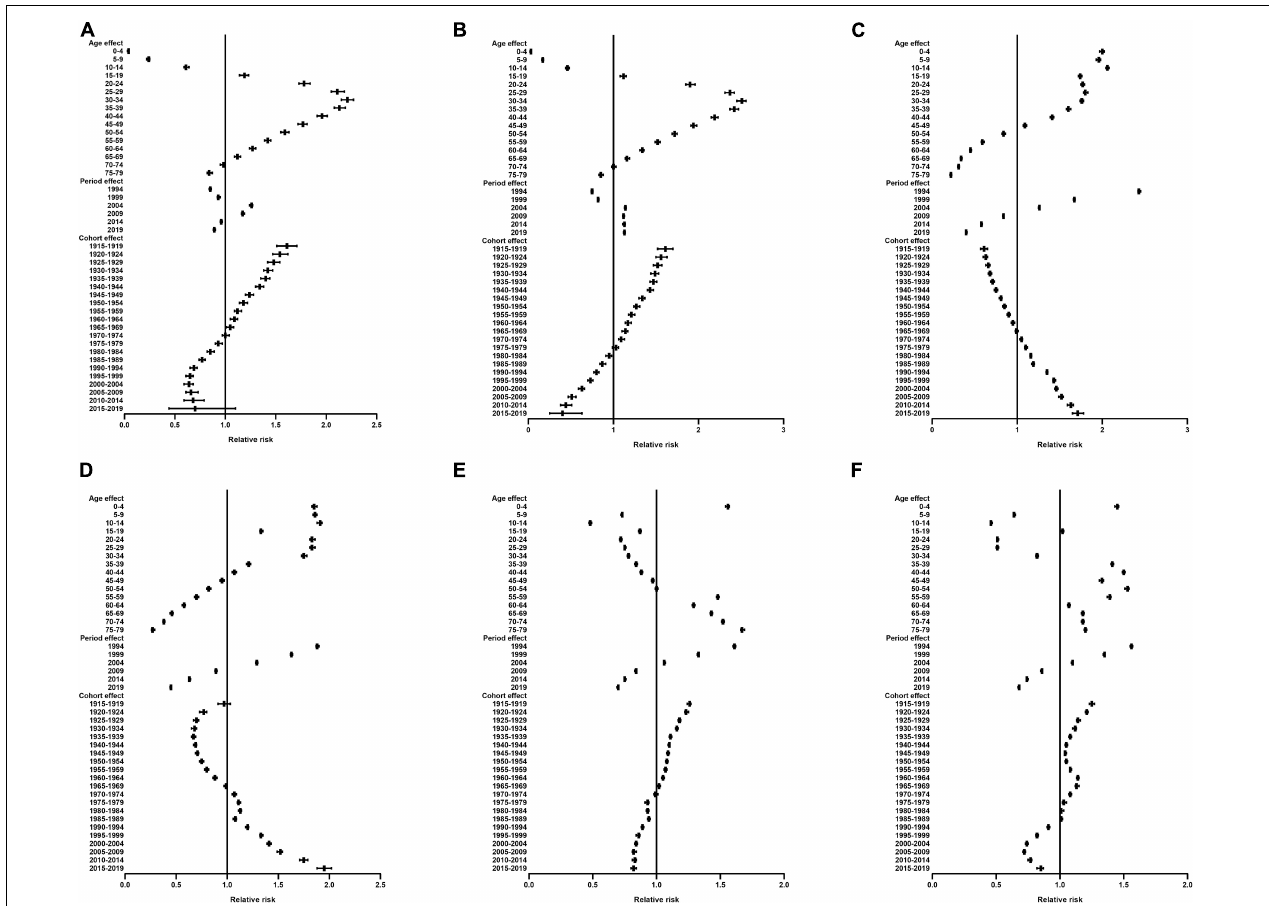
FIGURE 3 | Relative risk of iodine deficiency, vitamin A deficiency and dietary iron deficiency prevalence by sex in China from 1990 to 2019 due to age, period, and cohort effects. (A) Iodine deficiency in males. (B) Iodine deficiency in females. (C) Vitamin A deficiency in males. (D) Vitamin A deficiency in females. (E) Dietary iron deficiency in males. (F) Dietary iron deficiency in